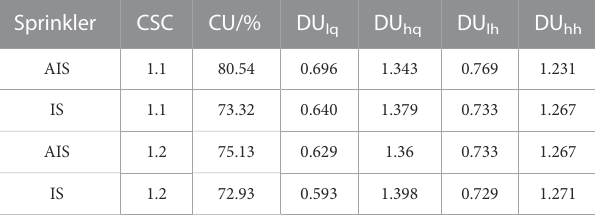
TABLE 3 Results of water uniformity coef fi cients with 250 kPa operating pressure. Sprinkler